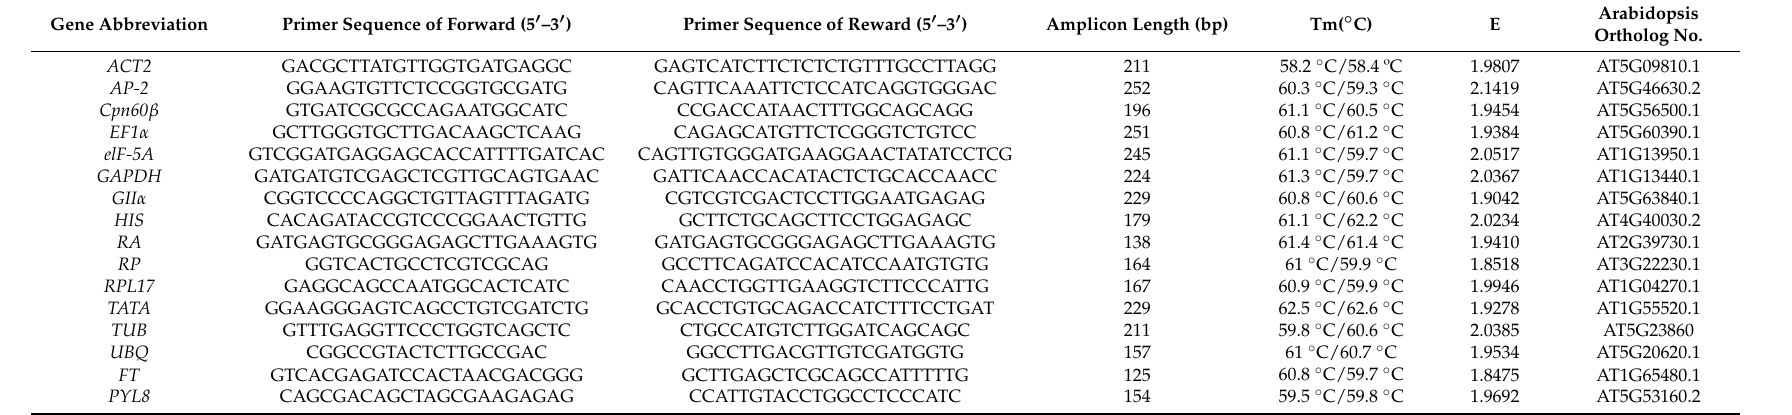
Table 1. Primer sequences and PCR amplification characteristics of the 14 selected reference genes and two target